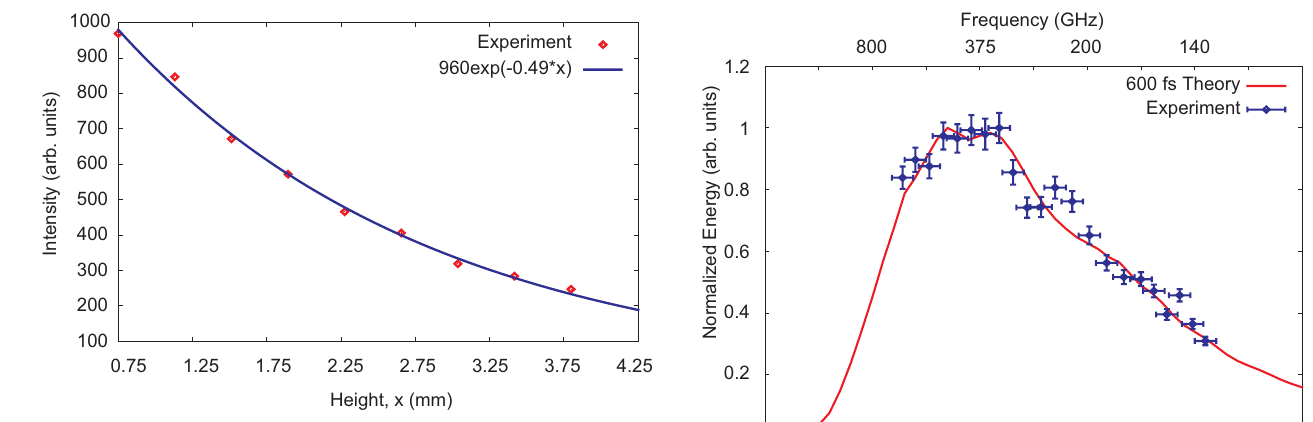
FIG. 4. (Color) Plot of the measured SPR intensity as a function of beam height above the grating.